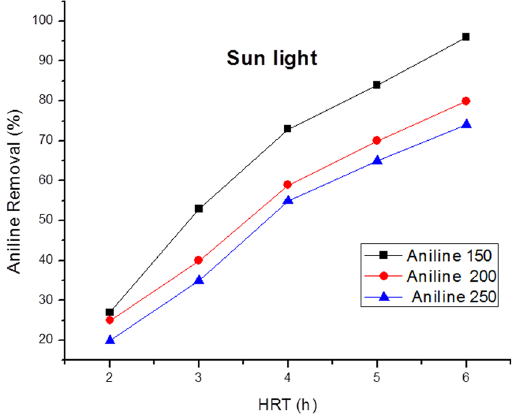
Figure 11. Various concentrations of Aniline under sunlight